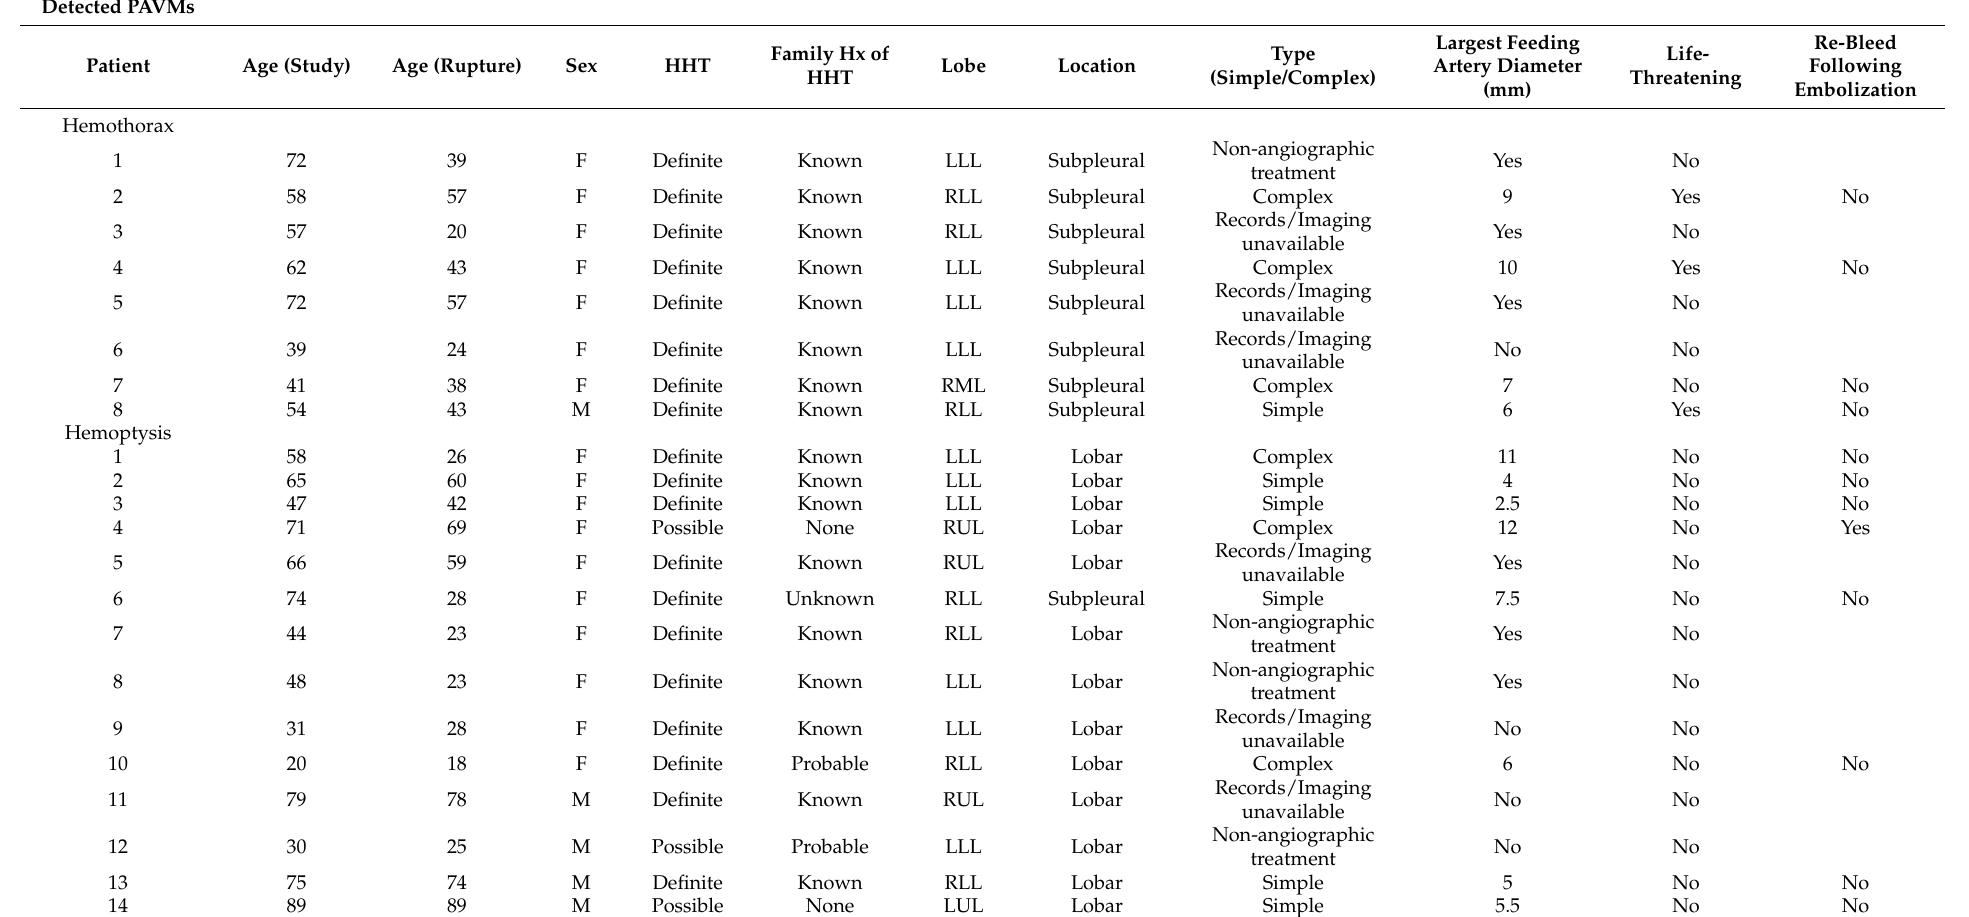
Table 1. Patient